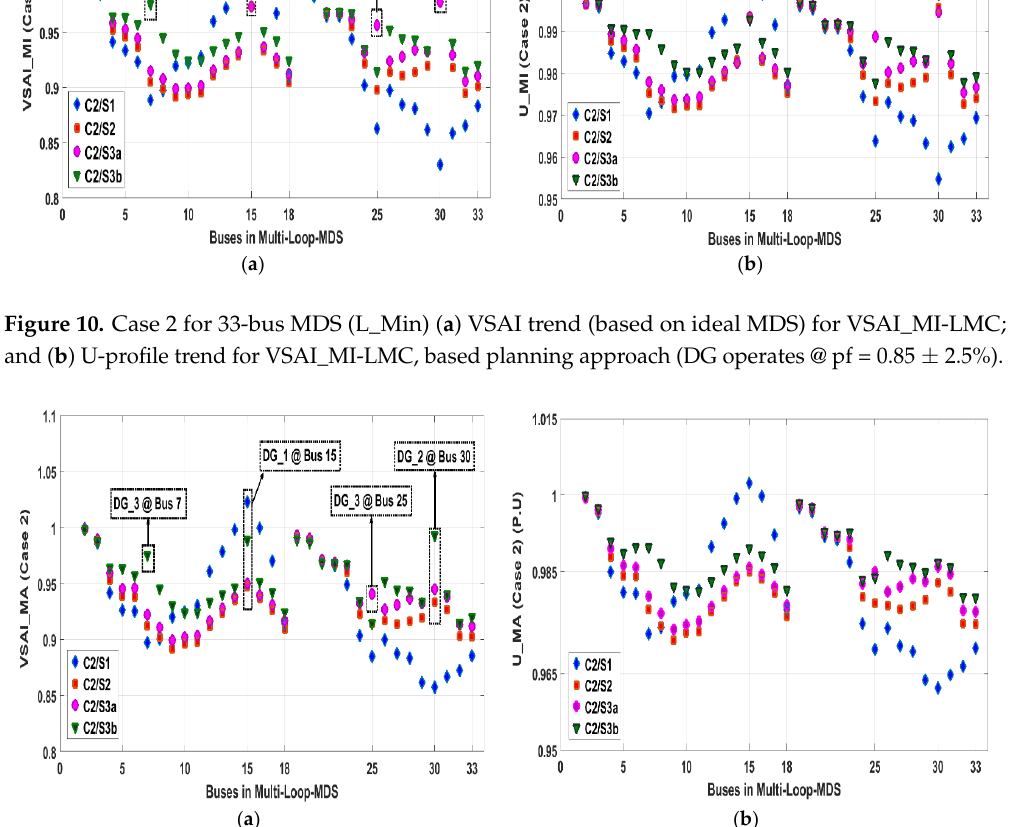
Figure 11. Case 2 for 33-bus MDS (L_Min) ( a ) VSAI trend (based on actual MDS) for VSAI_MA-LMC; and ( b ) U-profile trend for VSAI_MA- LMC, based planning approach (DG operates @ pf = 0.85 ± 2.5%).